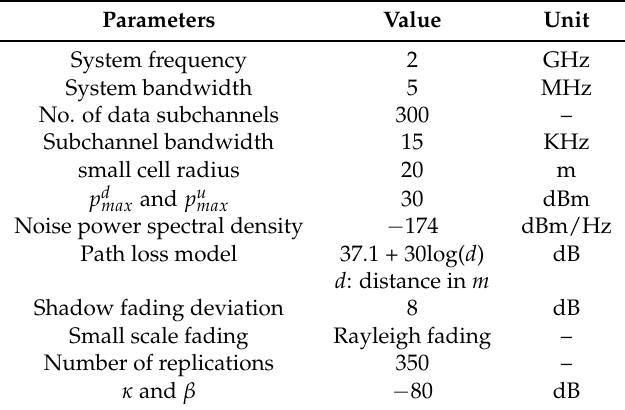
Table 1. Simulation